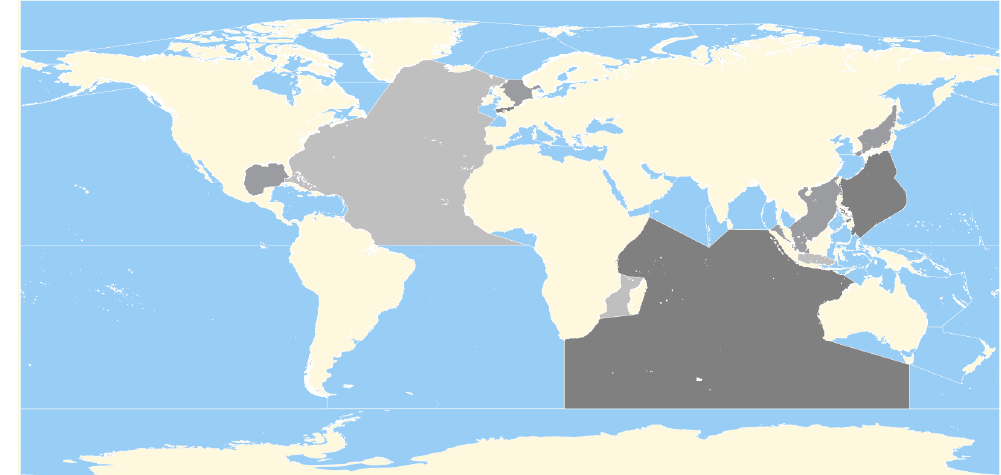
Figure 15. Snapshots of the English Channel sea currents U n c with 2-h difference from one another, by [35].